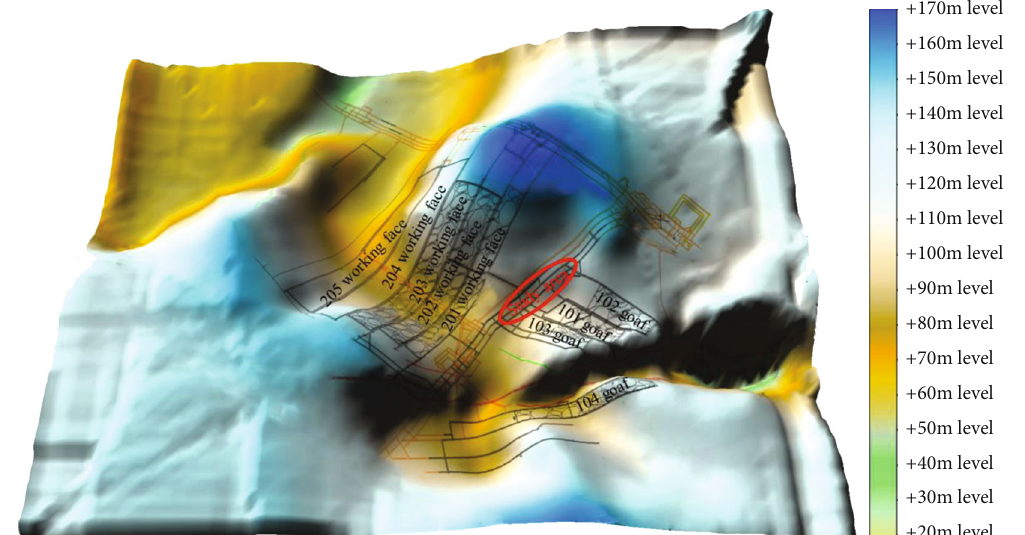
Figure 2: Surrounding environment and terrain of main